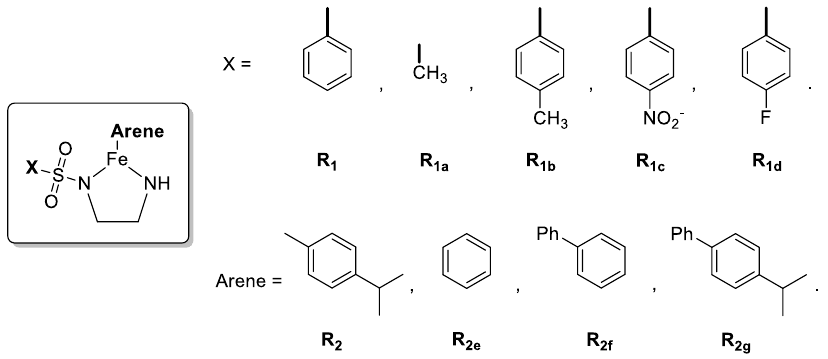
Scheme 2. New Fe complexes with methyl or various arene ligands. Table 1. Relative free energies between EDSs to lactic acid enantiomers ( TS 2,3- R and TS 2,3- S ) and the rate-determining states (RDSs) ( 5′ and TS 5,1 ) in catalytic cycles.